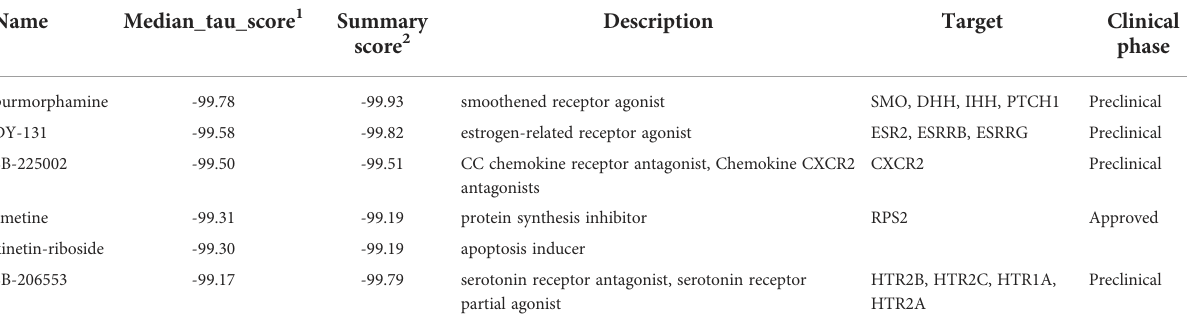
TABLE 1 Candidate compounds computed from CMap potentially targeting adipogenic